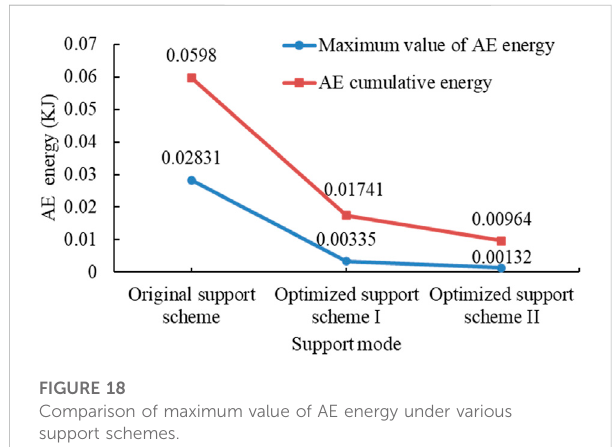
FIGURE 18 Comparison of maximum value of AE energy under various support